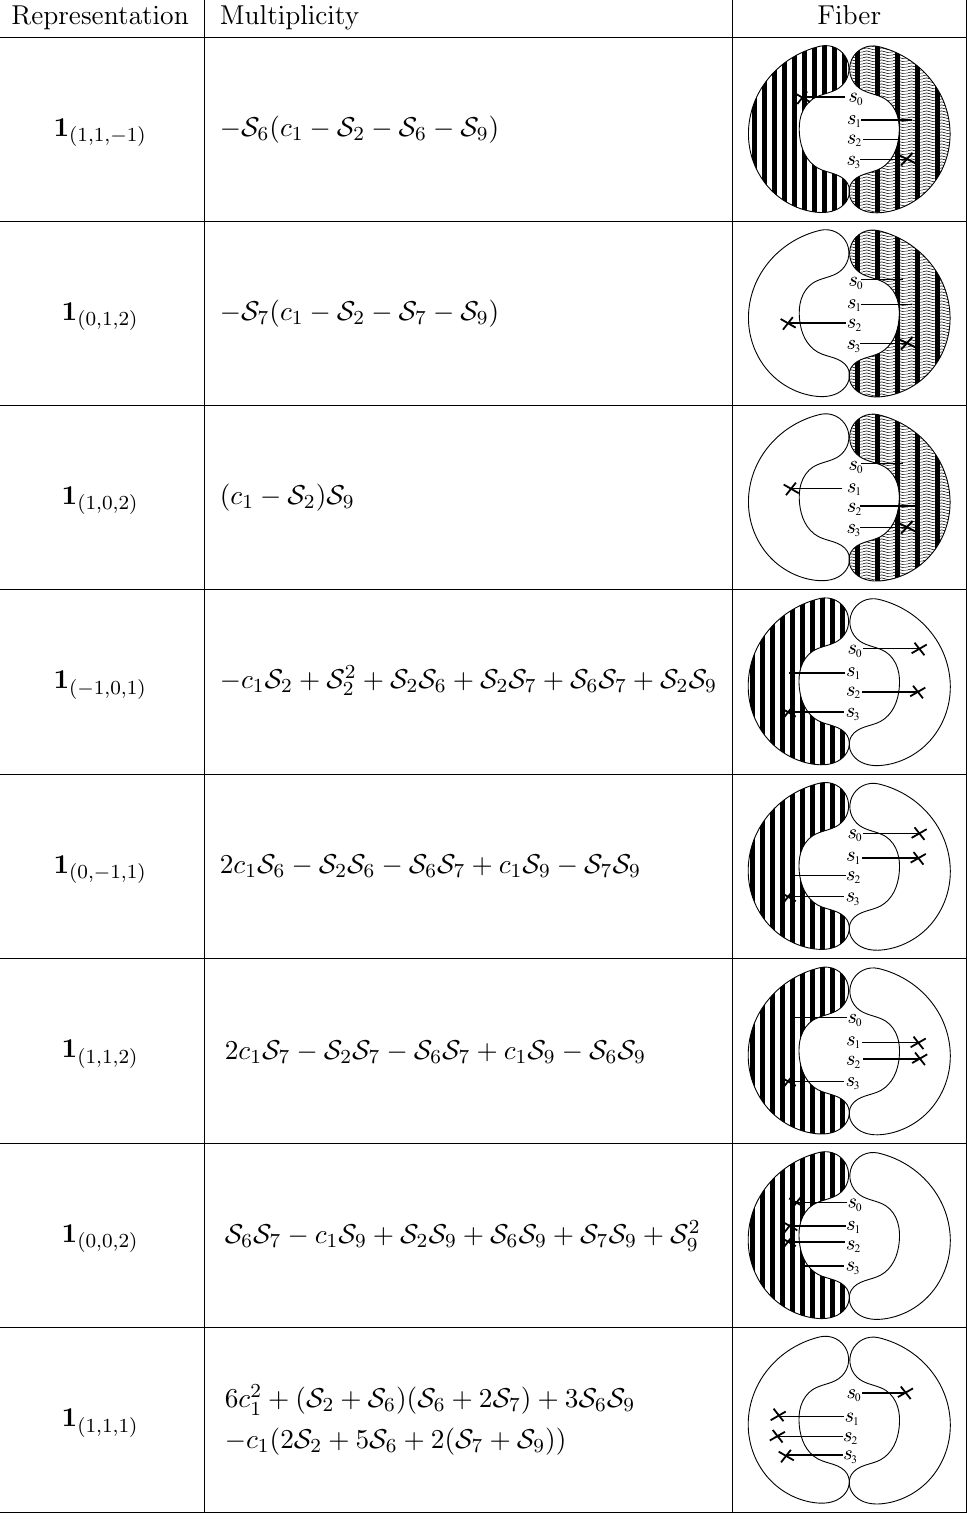
Table 7 . The first part of the summary of the matter representations and multiplicities from nef (67,0) with G = U(1) 3 . It is continued in table 8. We also depict the intersections of the fiber components with the